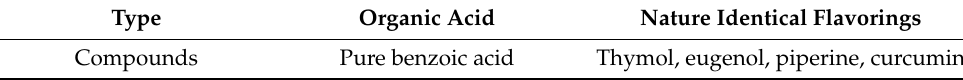
Table 1. Test compounds. Type Organic Acid Nature Identical Flavorings